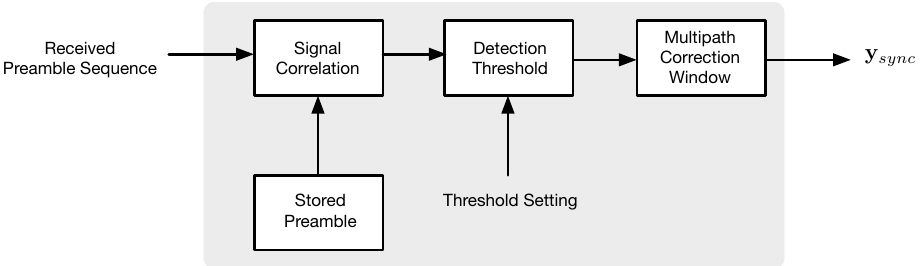
Figure 3. Frame-detection algorithm procedure for ZC preamble in TIBWB–OFDM receiver